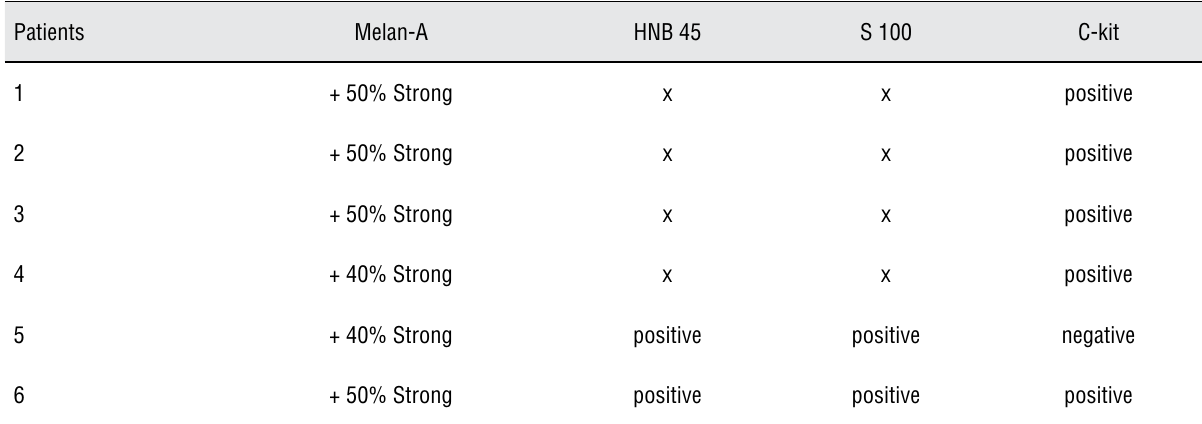
Table 3 - Immunohistochemical characteristics of tumors. Patients